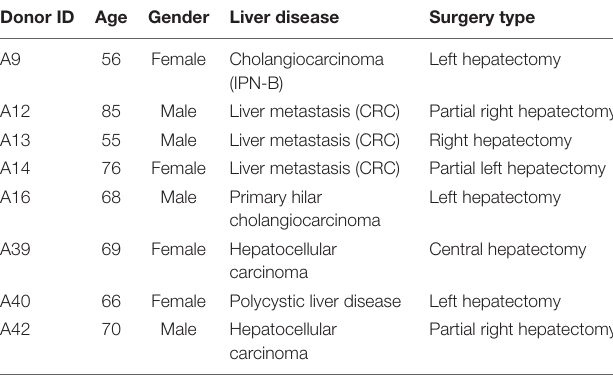
TABLE 1 | Patient